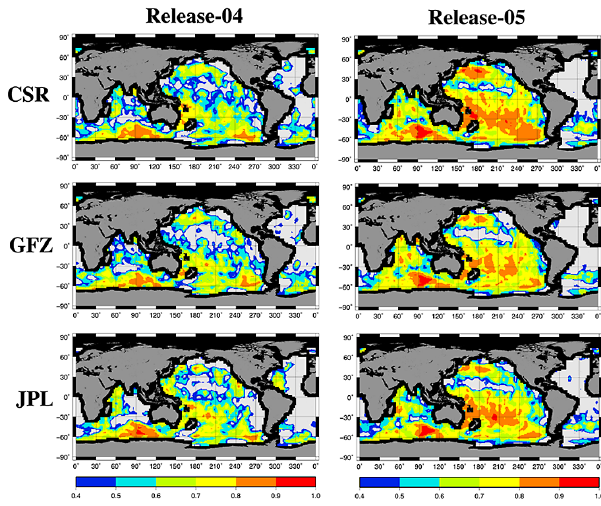
Fig. 5. Correlation between unsmoothed OBP from JPL ECCO and GRACE mapped OBP (destriped, 300km Gaussian) for Release- 04 (left column) and Release-05 (right column), using coefficients processed by CSR (top), GFZ (middle), and JPL (bottom). Only values greater than 0.4 (the 99% significance level) are shown.